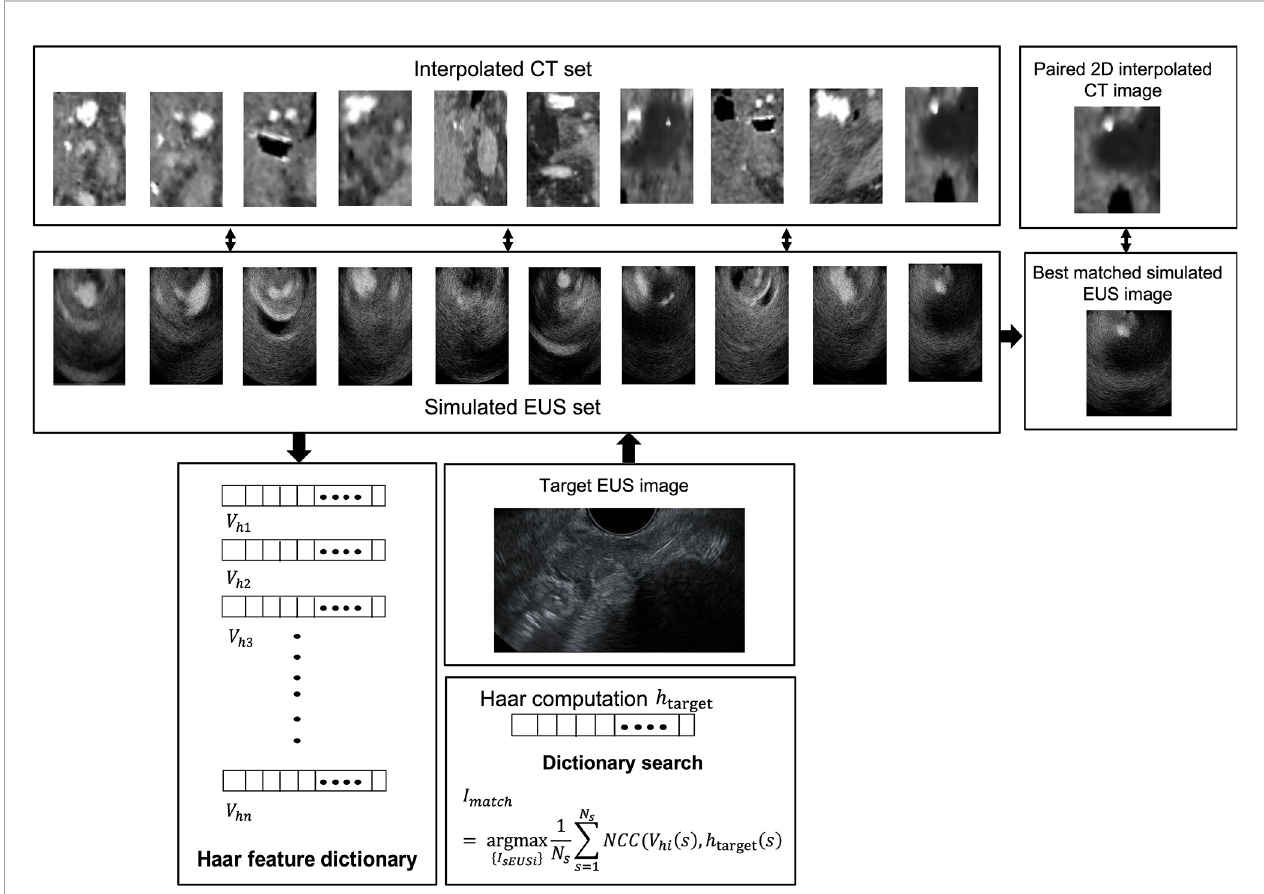
FIGURE 4 | The work fl ow of patient ’ s CT